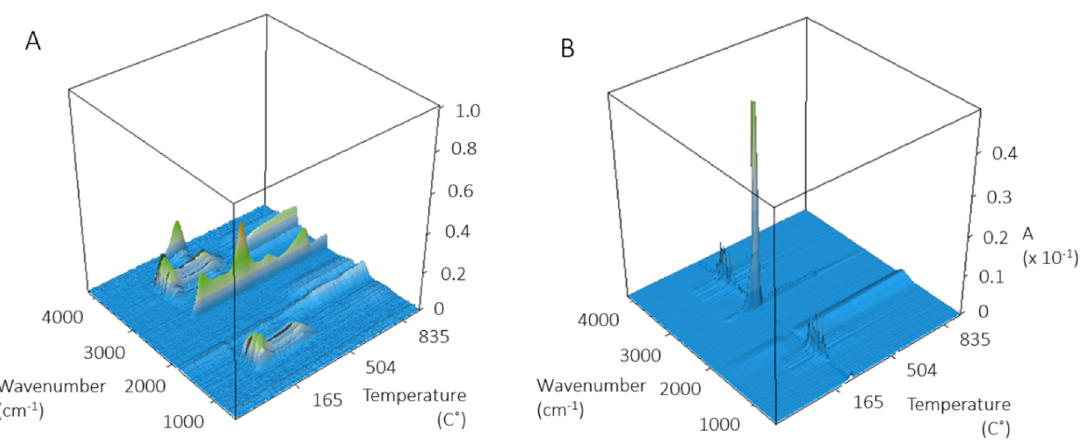
Figure 2. 3D FT-IR spectra of evolved gases from the TGA analysis of bare ZnO samples: ( A ) USRN-01, and ( B ) USRN-02. The analysis was carried out in an argon atmosphere. The signal at 3000–3200 cm -1 in panel A is due to a background issue.